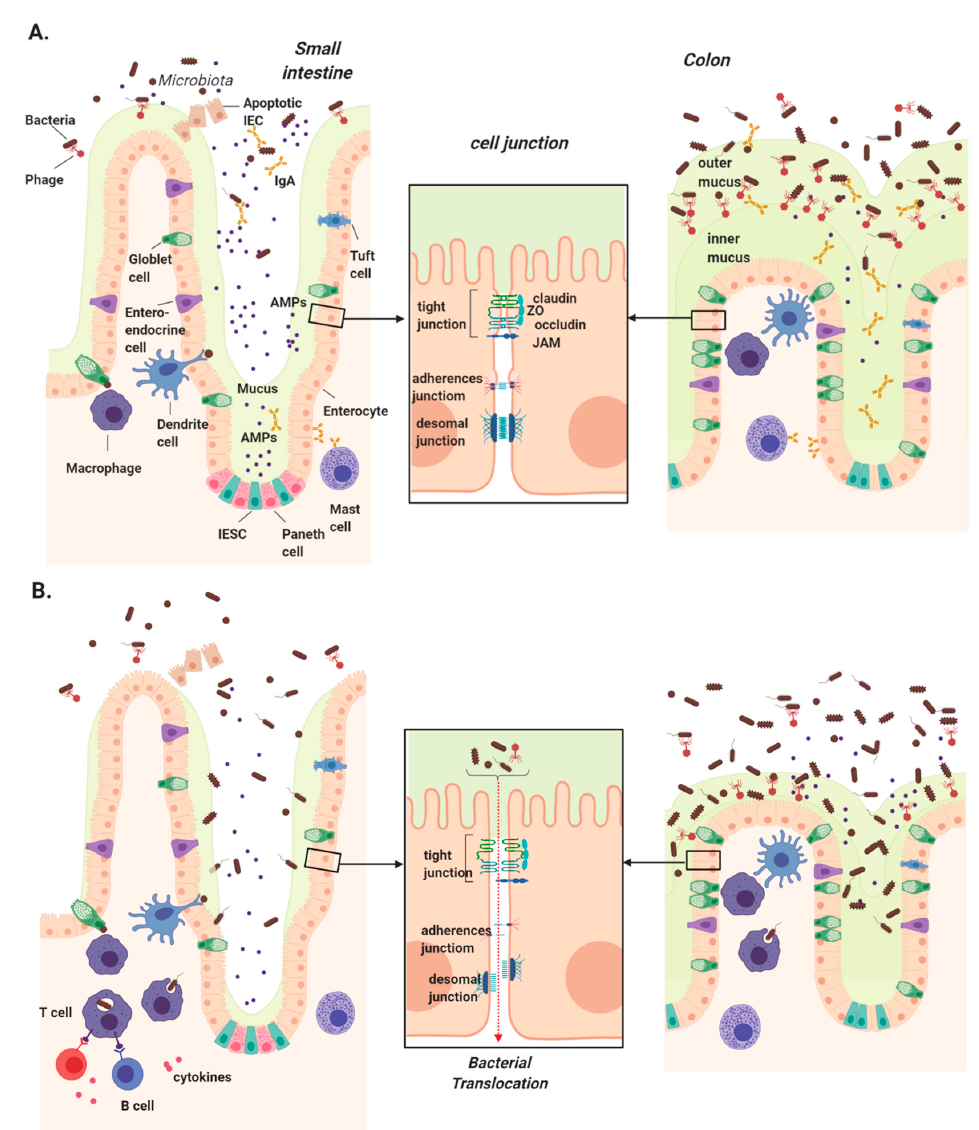
Figure 1. Intestinal mucosal barriers in health and chronic liver disease. ( A ) Several physical and chemical defenses make up the intestinal mucosa, which serves to protect us from luminal microbes. Intestinal epithelial stem cells (IESCs) located at the base of crypts give rise to all epithelial cells. Goblet cells secrete mucins to form a thin mucus layer in the small intestine and two thick layers in the colon, the innermost of which is devoid of bacteria. Enterocytes/colonocytes and Paneth cells secrete antimicrobial peptides (AMPs) primarily in the small intestine, while mast cells secrete IgA, which travels through the epithelium and is concentrated in the colon. Underlying the epithelium, dendritic cells and macrophages continuously surveil luminal contents using trans-epithelial dendrites. ( B ) Disruption of these physical barriers can lead to intestinal permeability and increased microbial translocation in chronic liver disease. These include the reduction of secreted mucus, AMPs, and IgA, permitting microbial access to the epithelial layer. Downregulation, altered localization, or rearrangement of tight junction components can also significantly impact intestinal permeability, allowing microbial translocation into the portal circulation where they are transported into the